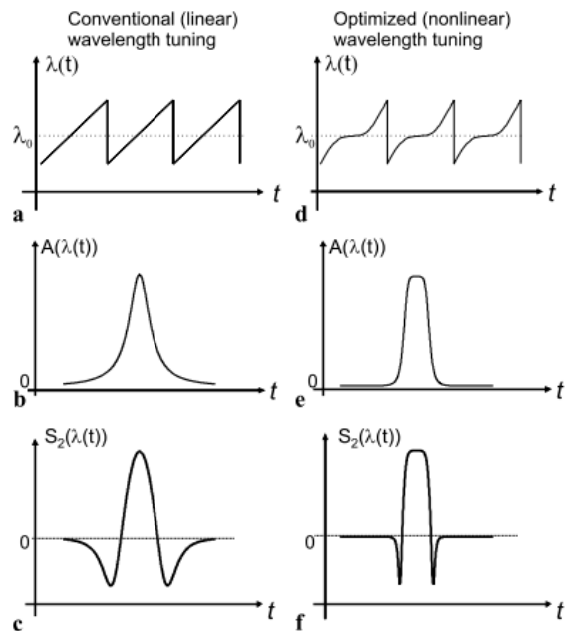
Figure 8. Schematic illustration of the wavelength scanning function: conventional (linear) ( a ) and optimized (nonlinear) ( d ). The resulting spectrum waveform is shown for direct spectroscopy in ( b ) for linear scanning and ( e ) for nonlinear scanning as well as for WMS (second harmonic detection) in ( c , f ). Figure adapted from [94].